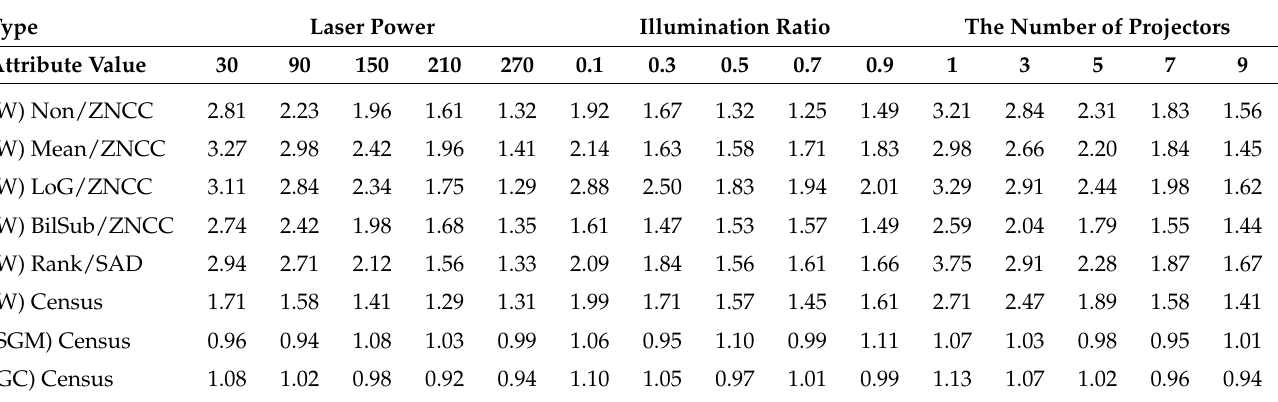
Table 3. RMS errors of real active images